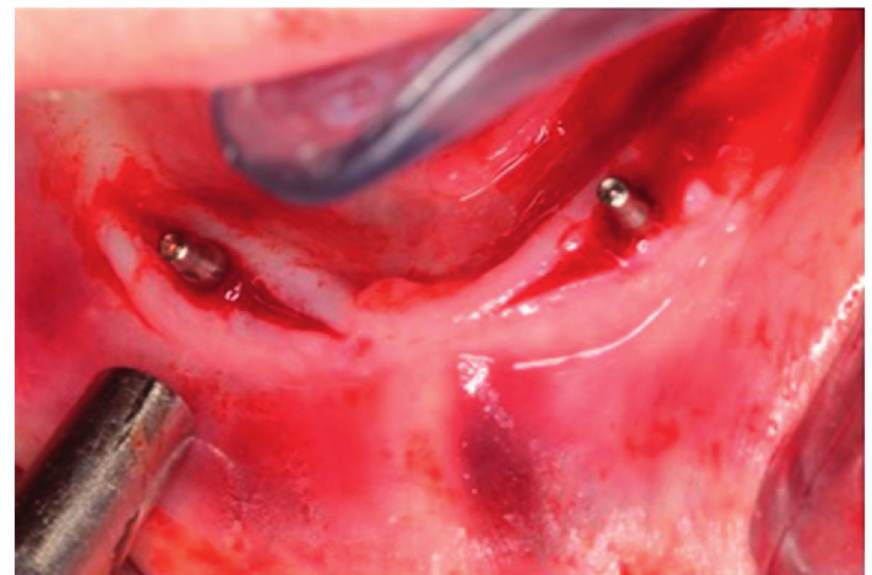
Figure 1: Checking parallelism between implants by the parallel pins.